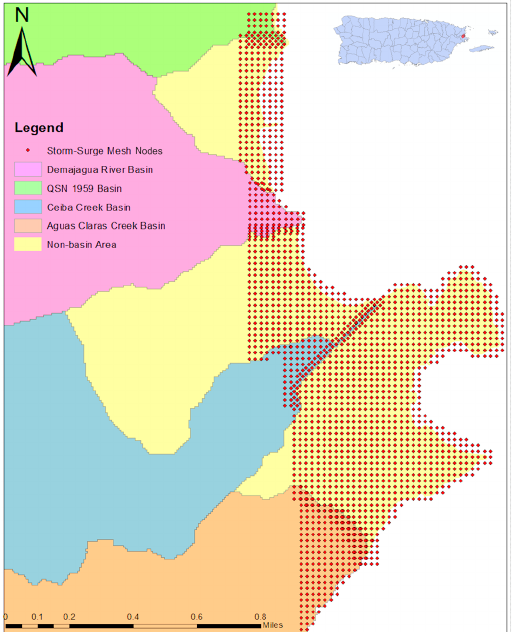
Figure 10. Vertices of the storm surge mesh (dots) within the area of interest for the coupled model. Each point represents a “ feature point ” in the GSSHA hydrologic model, where the point contains the water surface elevation time series from the ADCIRC + SWAN model. The mesh has a spatial resolution of 30-m, with exception of the Non-Basin Area between the Ceiba and Aguas Claras Watershed, which has a spatial resolution of 90-m.